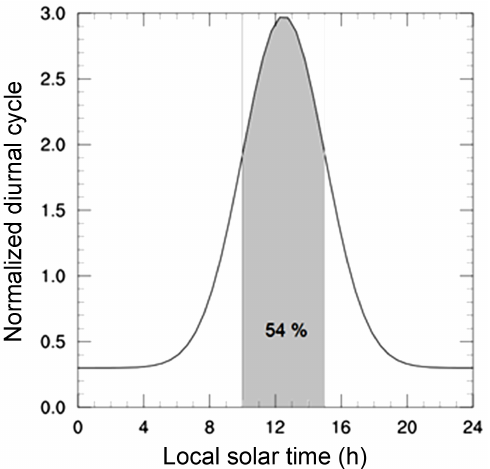
Figure 2. The course of the diurnal cycle assumed for fires in boreal forests. In the individual simulations this diurnal cycle is overlaid on the daily values of fire size, fire intensity, and emission strength.